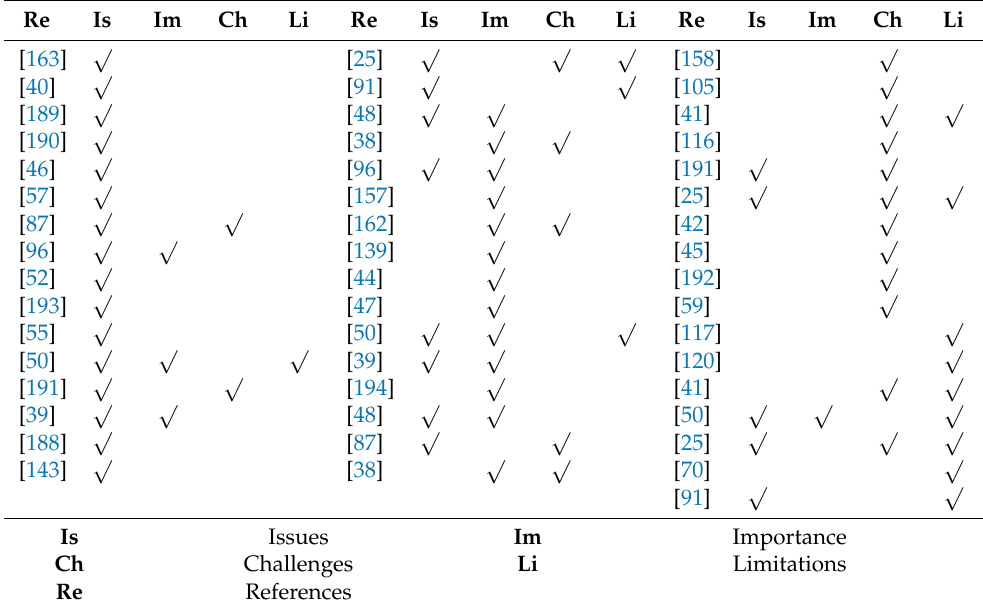
Table 9. Limitations, challenges, issues, and importance of blockchain application in